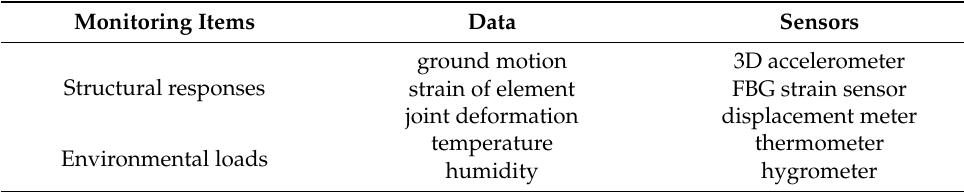
Table 1. The original sampling frequency of the five types of sensors is 50 Hz. Table 1. SHM contents and corresponding Table 1. SHM contents and corresponding sensors.